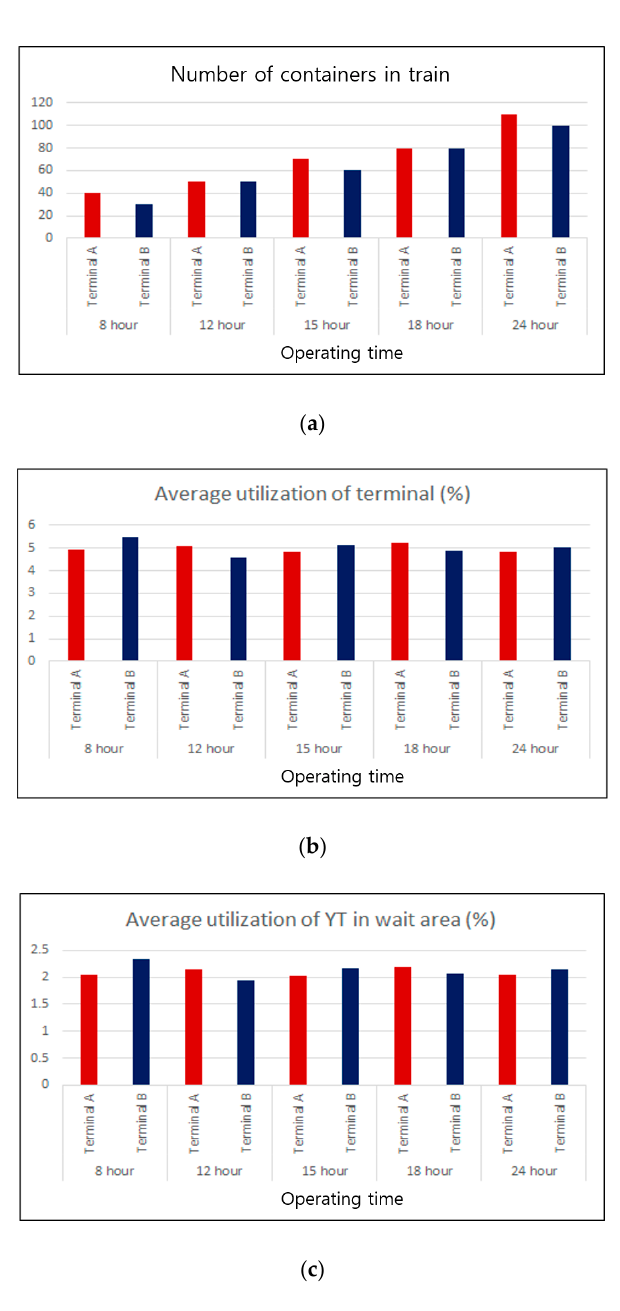
Figure 16. Simulation results for operating time in one direction with a single train, with a travel time of 1 h between terminals A and B: ( a ) number of containers on the train; ( b ) average utilization of terminal; ( c ) average utilization of yard tractor in waiting area.